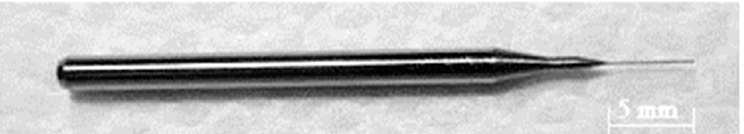
Figure 4. Commercially available spindle micro-tool without the screw slot. Diameter of shank: 3 mm. Diameter of tool: 0.15 mm.